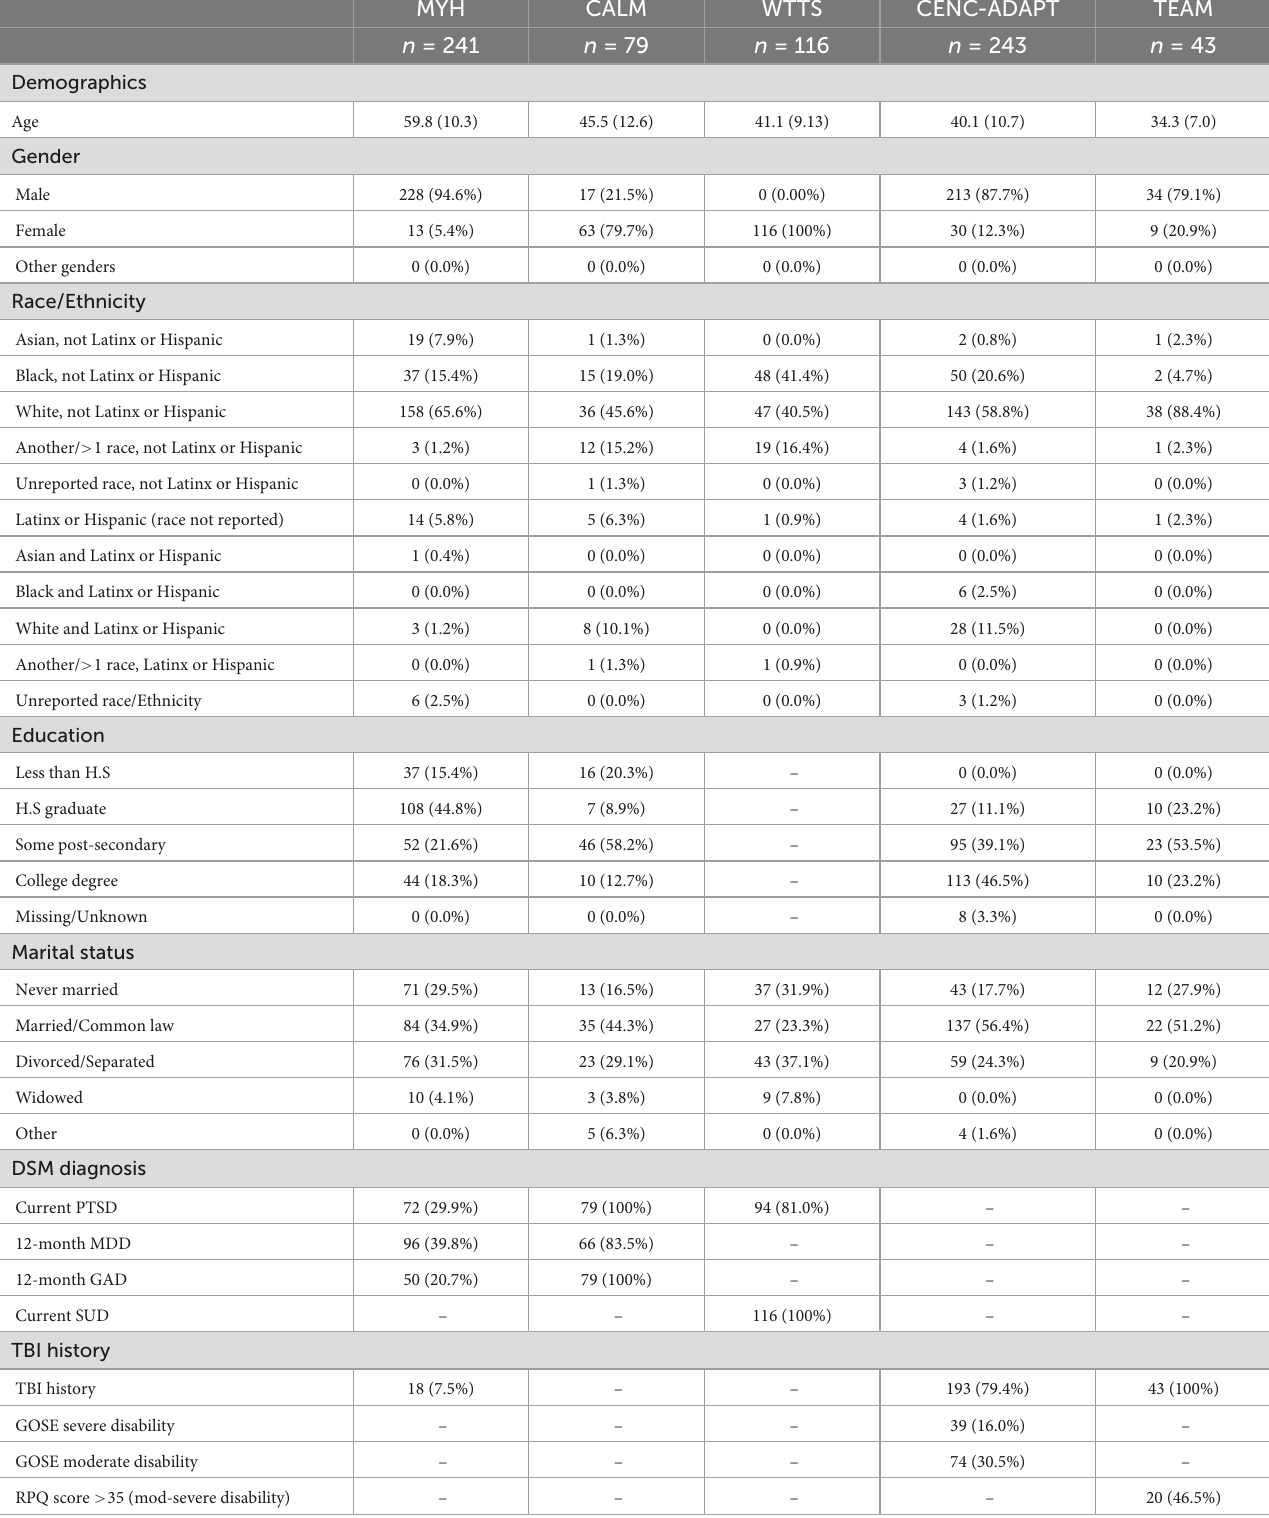
TABLE 2 Sociodemographics and select clinical characteristics of each study